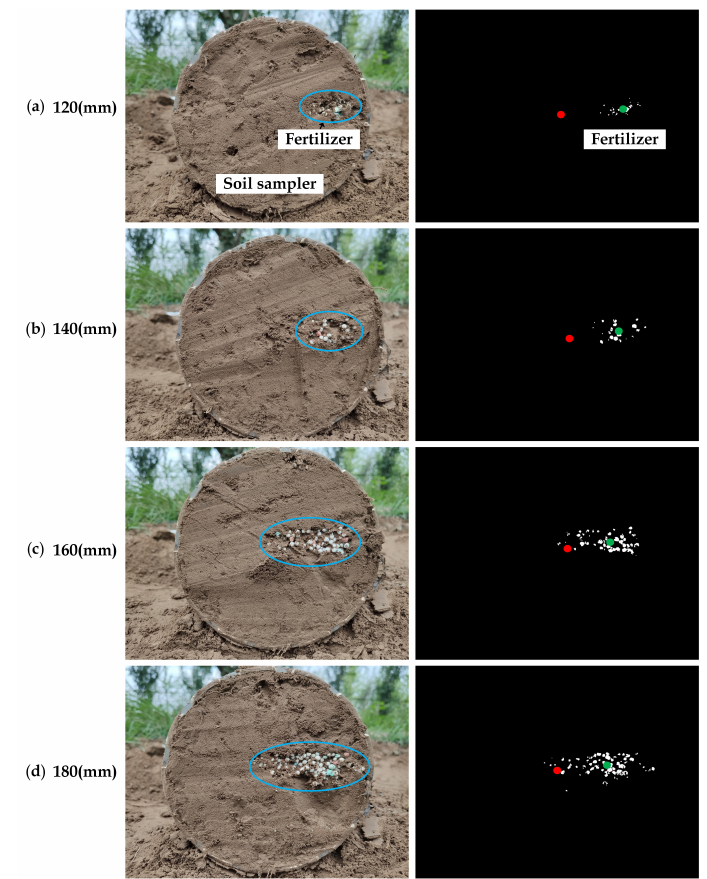
Figure 8. Fertilizer distribution maps at different soil depths: ( a ) 120 mm; ( b ) 140 mm; ( c ) 160 mm; and ( d ) 180